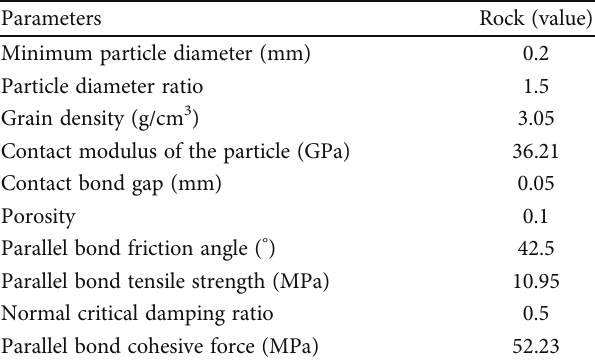
Figure 2: Veri fi cation of the experimental and numerical results. Table 1: Microscopic parameters of the